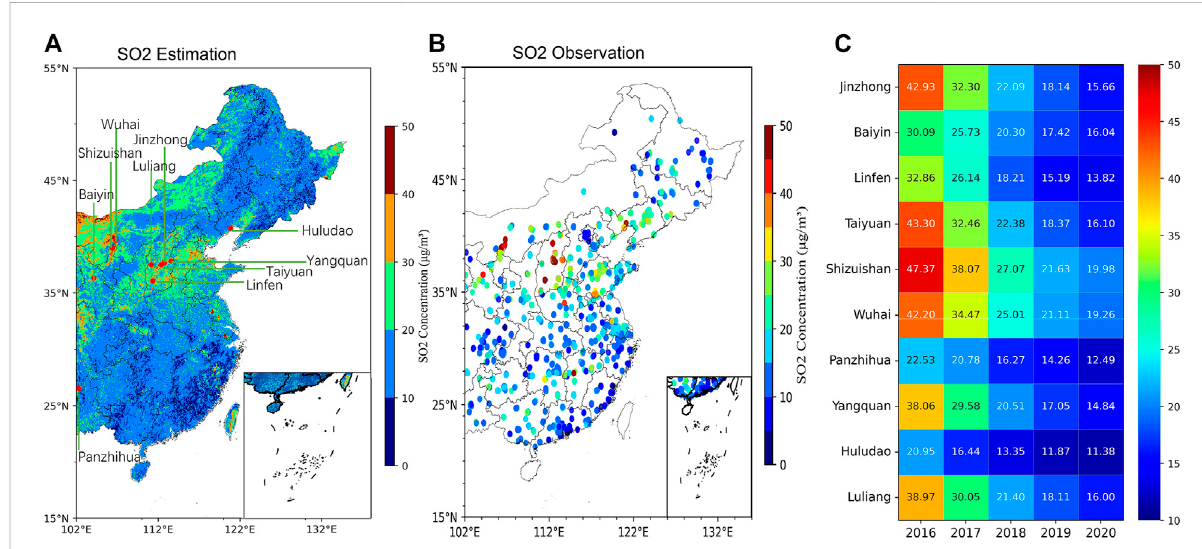
FIGURE 7 (A) The spatial distribution of the annual mean value of SO 2 between 2016 and 2020 predicted by the model ( μ g/m 3 ), (B) the spatial distribution of the annual average SO